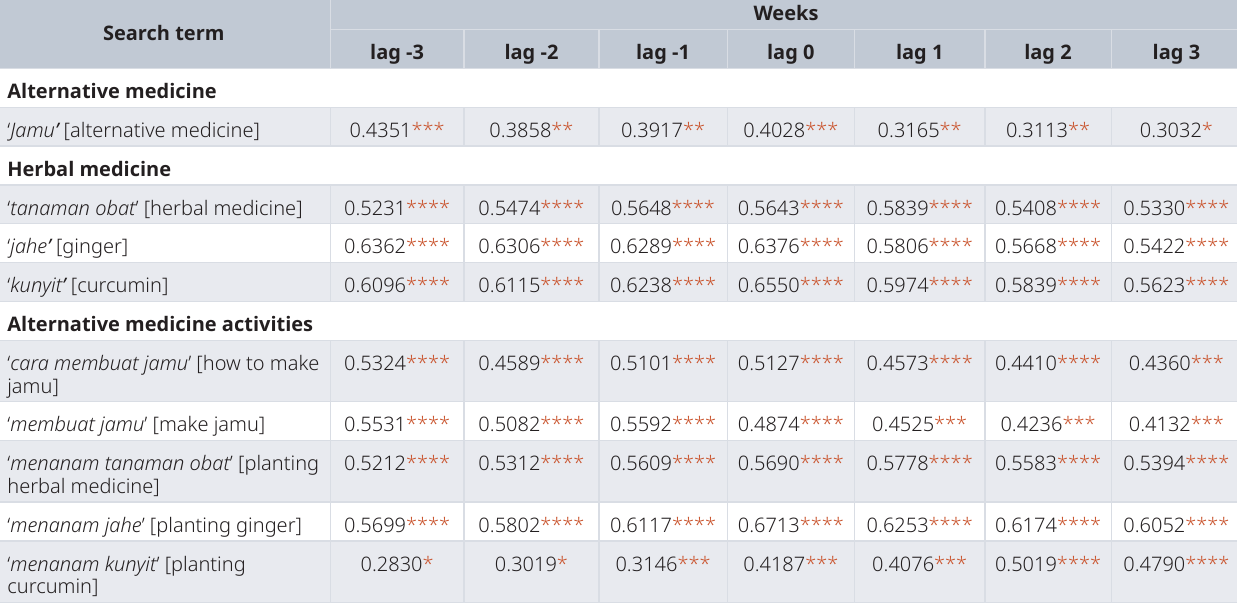
Table 1. Correlation between Google Relative Search Volume and COVID-19 cases in Indonesia.